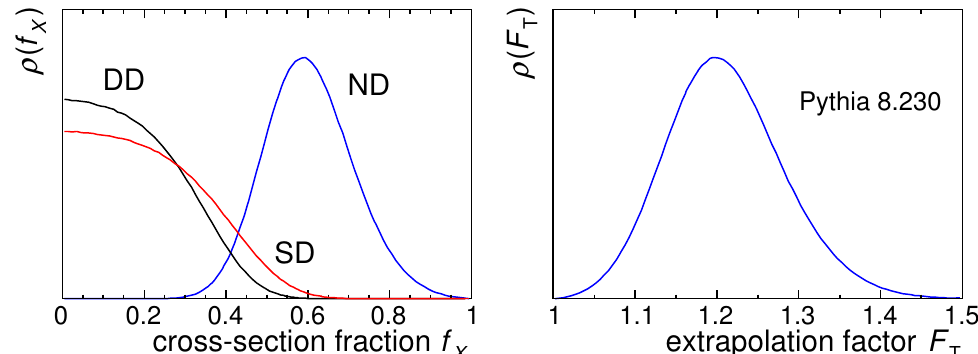
Figure 2 . Posterior densities of (left) the cross-section fractions f X for non-di(cid:11)ractive (ND) double- di(cid:11)ractive (DD) and single-di(cid:11)ractive (SD=SDA+SDB) contributions, and (right) of the extrapo- lation factor F T